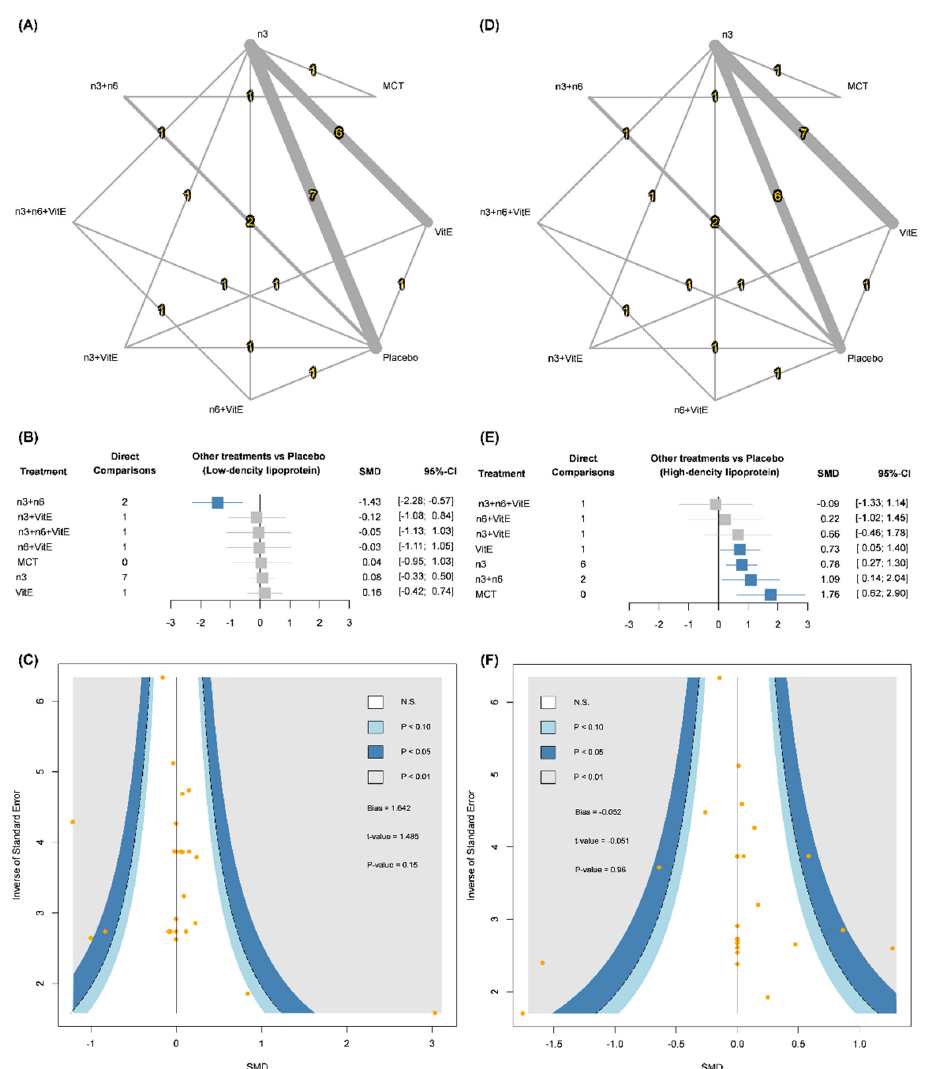
Figure 2. ( A ) Network plots of low-density lipoprotein, ( B ) forest plot of low-density lipoprotein, ( C ) funnel plot of low-density lipoprotein, ( D ) network plots of high-density lipoprotein, ( E ) forest plot of high-density lipoprotein and ( F ) funnel plot of high-density lipoprotein. CI, confidence interval; MCTs, medium chain triglycerides; n3, omega-3 fatty acids; n6, omega-6 fatty acids; SMD, standardized mean difference; Vit E, vitamin E. Results in the consistency model without direct comparison can be estimated by Bucher’s adjusted indirect comparison method.